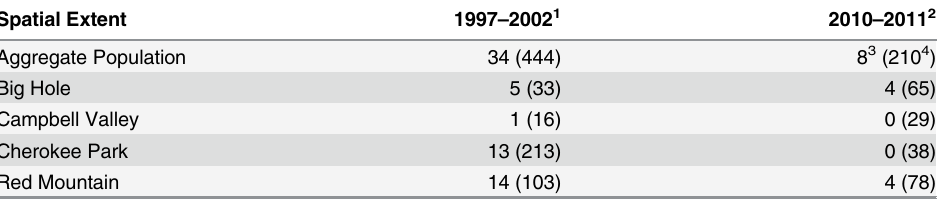
Table 4. Female deer CWD test results.